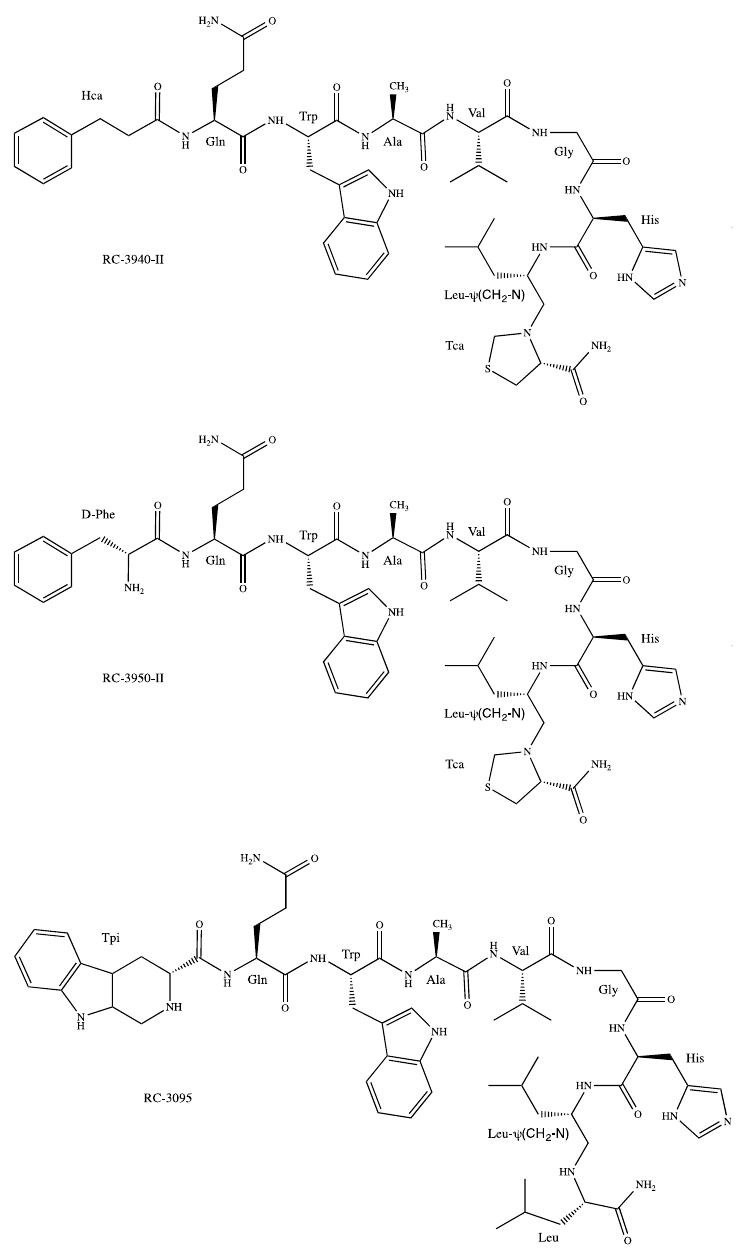
Figure 10. Structure of the GRP-R antagonists RC-3940-II, RC-3950-II and RC-3095, where Tpi corresponds to tetrahydro-1H-pyrido[3,4- b ]indole, Hca corresponds to desaminophenylalanine and Tac corresponds to thiazolidine-4-carboxylic acid.